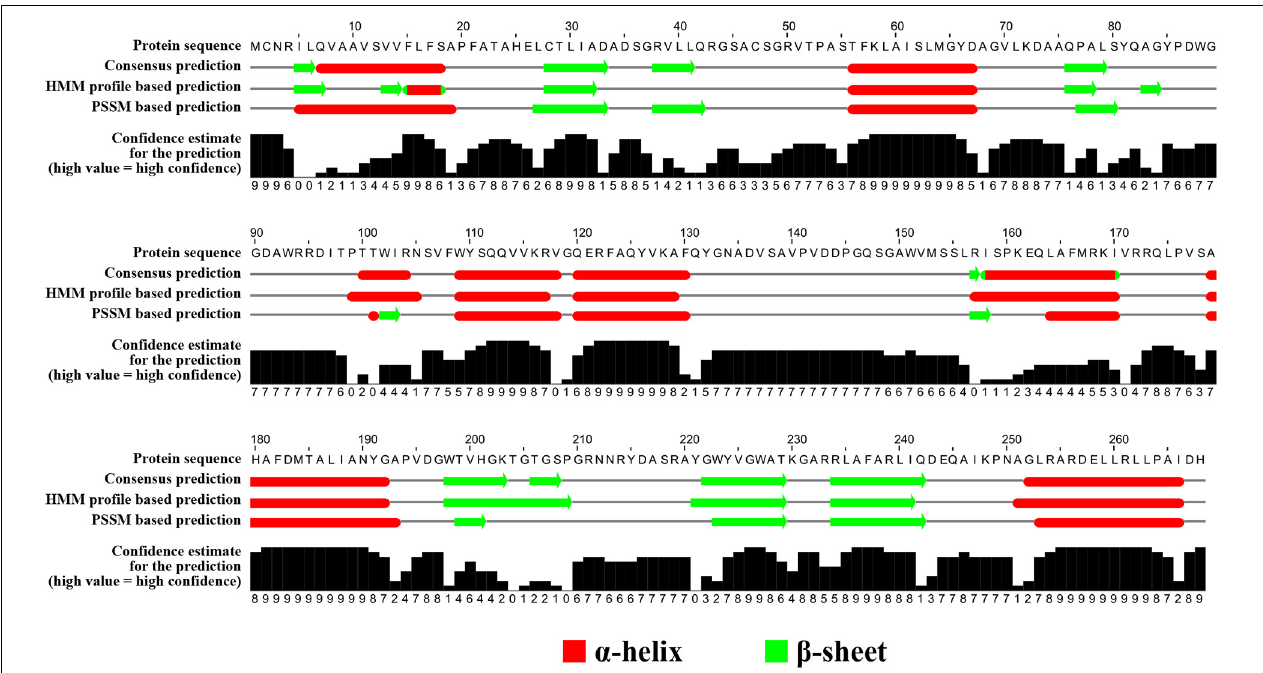
FIGURE 3 | Secondary structure of OXA-926. The secondary structure was predicted using the neural network-based web service JPred4 (Drozdetskiy et al., 2015) with the default settings. Secondary structure elements, α helixes, β sheets, and 3 10 -helixes (representing by η ), are indicated. β -strands are rendered as arrows, and strict α - and β -turns are shown as TTT and TT letters,